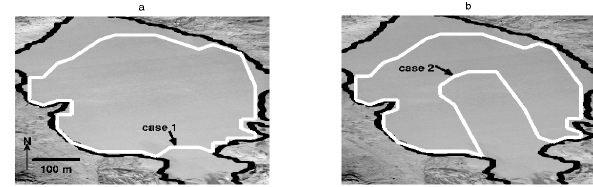
Fig. 8. Modelled deglaciated area (thick white line) with the calv- ing criterion (case 1) (a) and with surface melting alone (case 2) (b) from 2000 to 2006; the photograph in the background corre- sponds to the state of the lake in 2006; the thick black line indicates the lake bank.